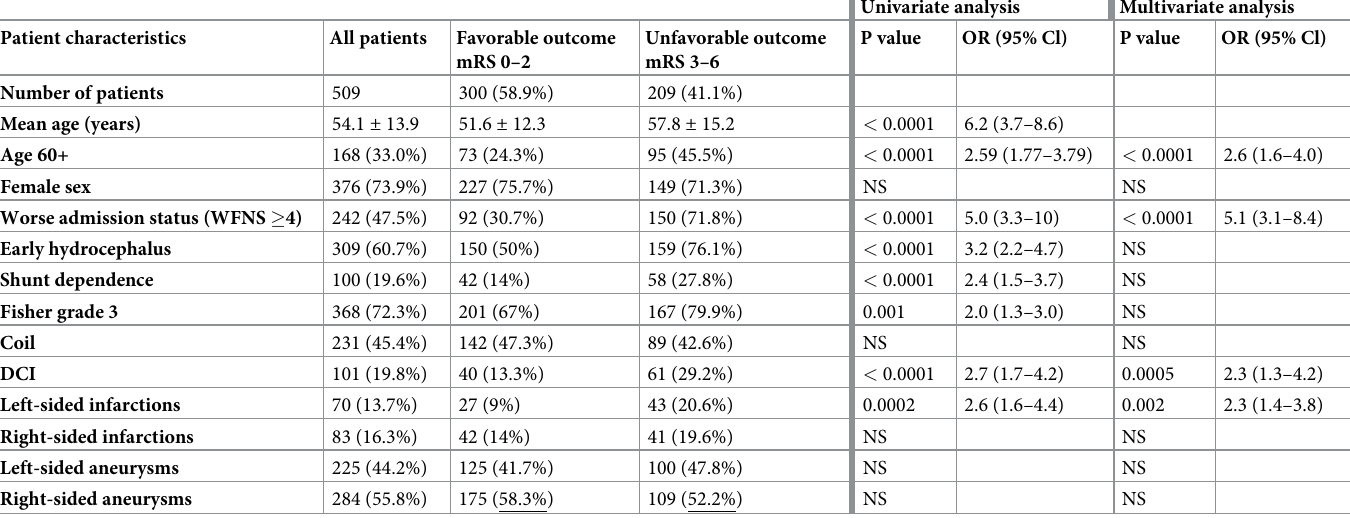
Table 2. Outcome characteristics in all patients (uni- and multivariate